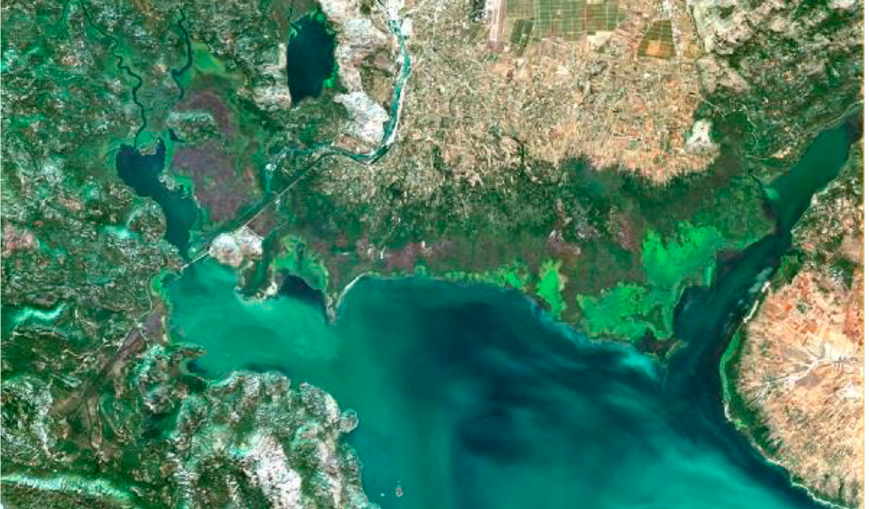
Figure 1. Skadar Lake, satelite map, 3 D (source of the image